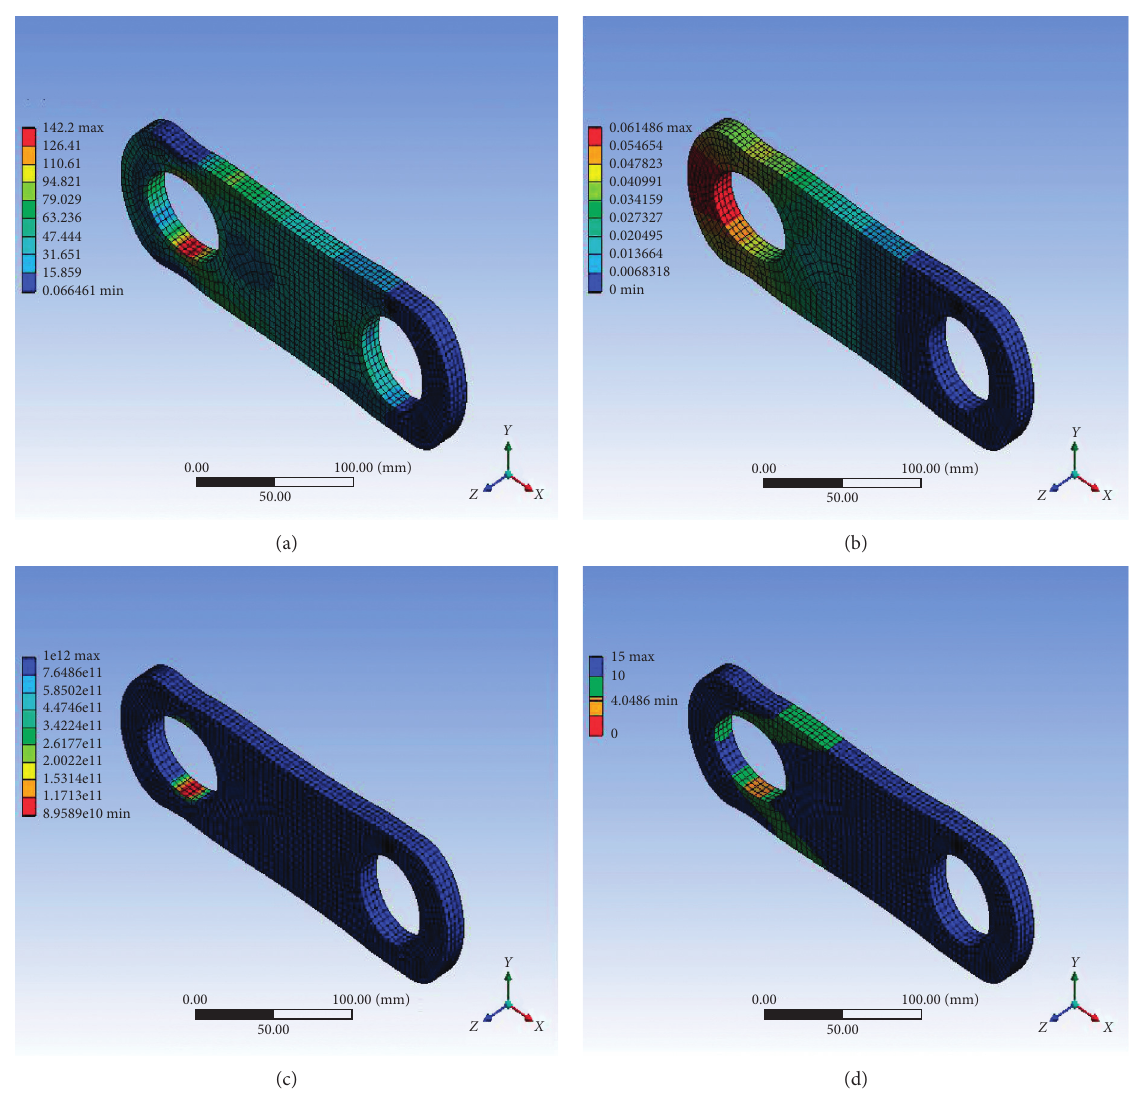
Figure 16: Simulation results for chain link with a modeled crack and neck radius 831.9 mm ( X � 3mm): (a) equivalent stress, (b) deformation, (c) fatigue life, and (d) safety